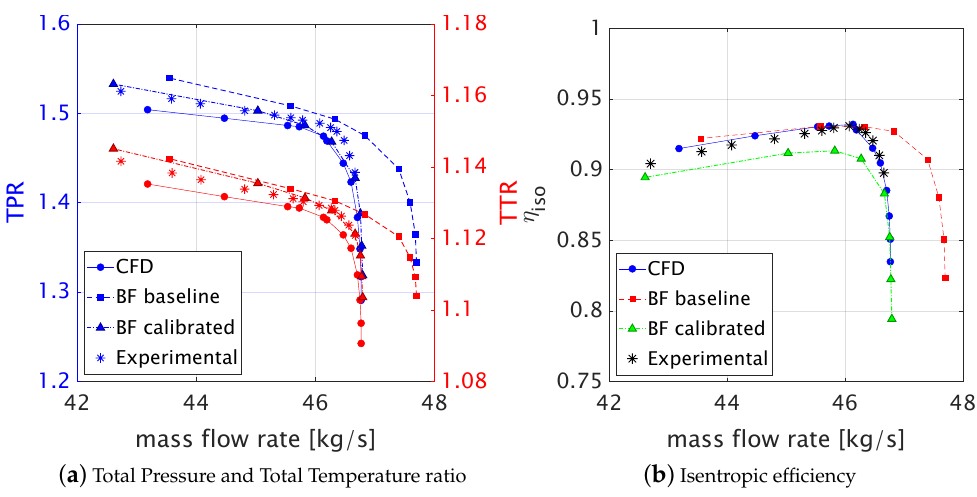
Figure 11. Fan characteristic maps using baseline and calibrated BFM vs. CFD reference solution and experimental data.